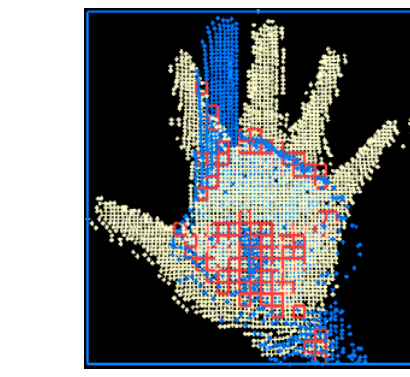
Figure 10. Methodology of comparison of two hand